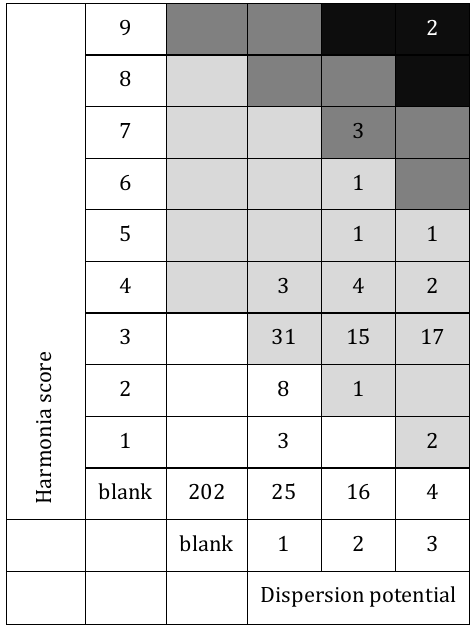
Table 3. The distribution of species according to their HARMONIA score and dispersion potential score (n= 341). Non-native species were allocated to different risk categories based on ISEIA score: 11-12 Black list, 9-10 Watch/observation list, 4-8 C list